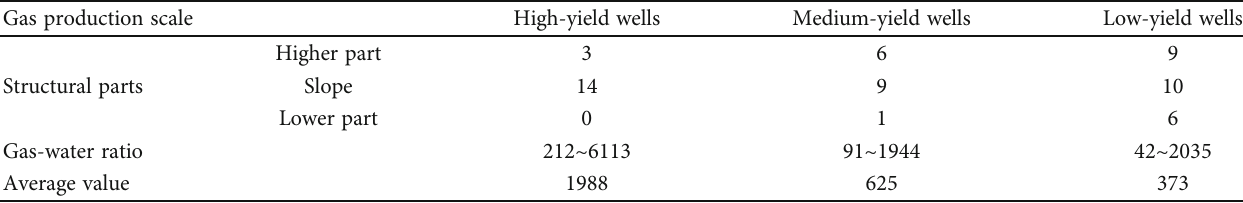
Table 4: The produced gas-water volume ratio of typical CBM wells and distribution of structural parts in the Fanzhuang block.